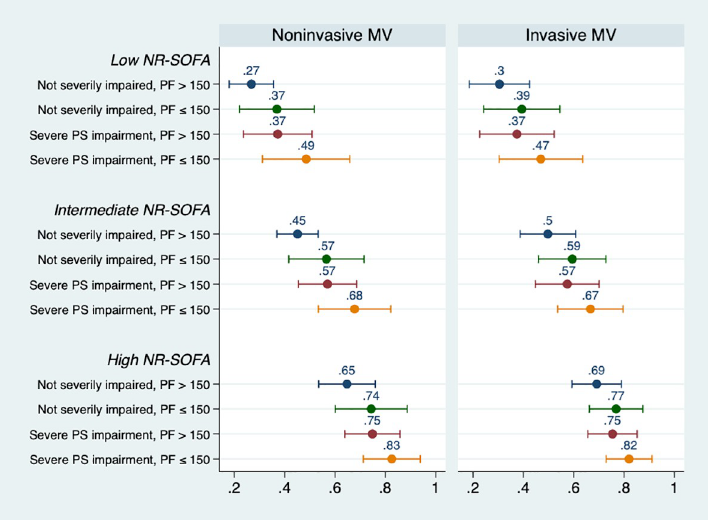
Fig 3. Marginal probability of hospital mortality according to the initial strategy of mechanical ventilation and three major patient characteristics. The x-axis represents the probability of the outcome (hospital mortality) according to representative values of covariates, stratified according to the initial strategy of mechanical ventilation (noninvasive ventilation or invasive mechanical ventilation). For example, a patient who was initially under noninvasive ventilation, with an intermediate NR-SOFA, not severely impaired and with a P a o 2 /F i o 2 ratio � 150 had a predicted probability of hospital mortality of 57%. MV: mechanical ventilation; PF: P a o 2 /F i o 2 ratio; PS: performance status; NR-SOFA: non-respiratory sequential organ failure assessment; Low-NR SOFA represents a value of 0; intermediate represents a value of 4; high represents a value of 8.